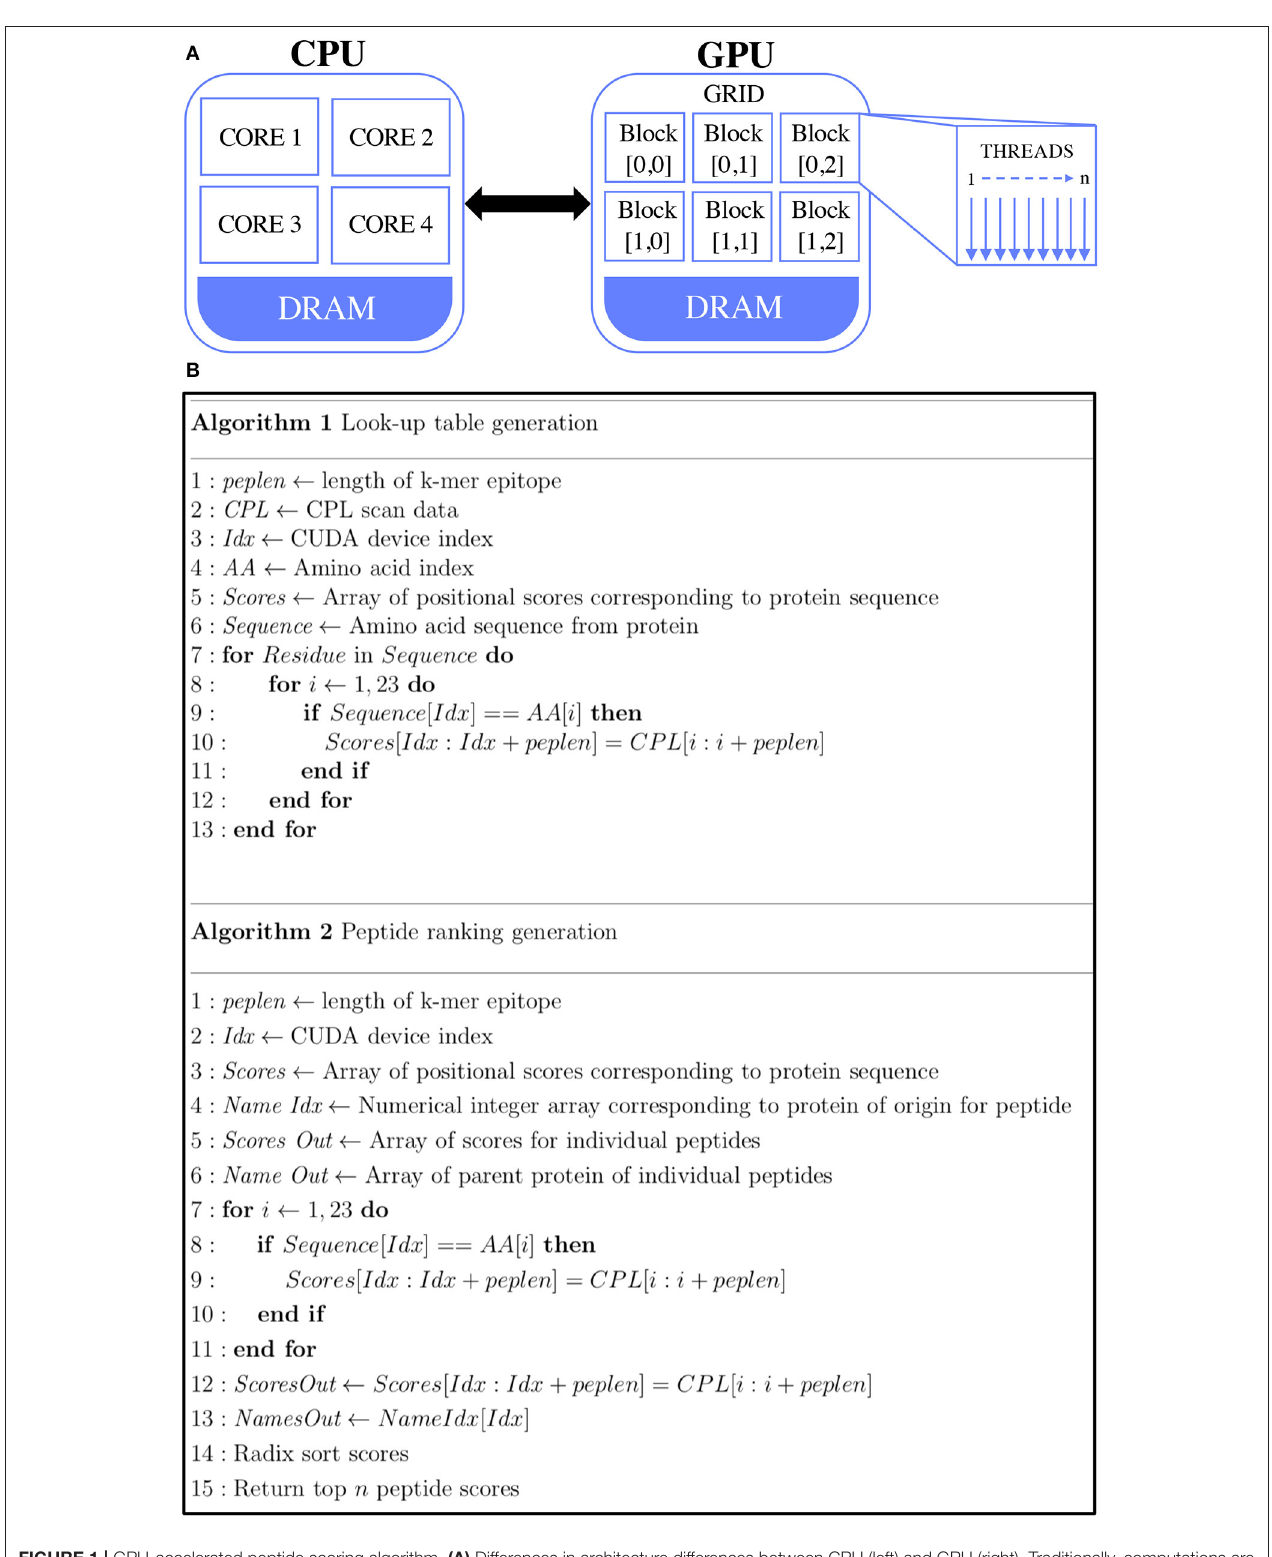
FIGURE 1 | GPU-accelerated peptide scoring algorithm. (A) Differences in architecture differences between CPU (left) and GPU (right). Traditionally, computations are performed by transferring data from global memory to the CPU cores. GPU computing allows for the transfer of data from global memory to device memory, where the GPU cores can access them. (B) Pseudocode of the two main GPU parallel functions. Algorithm 1 (top) describes the look-up table generation of the peptides and algorithm 2 (bottom) describes the calculation of the agonist likelihood scores.